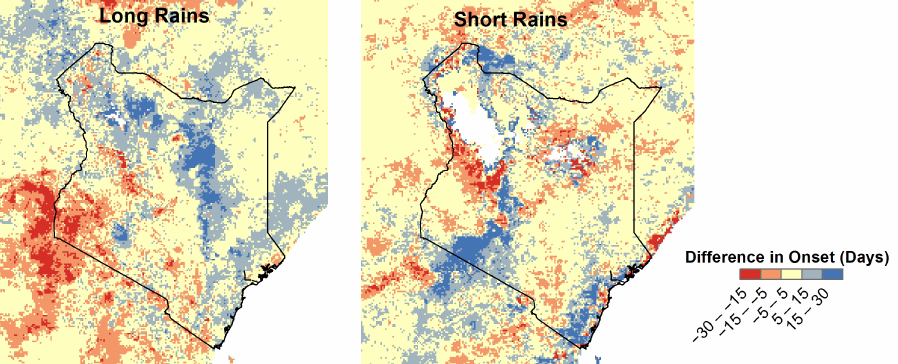
Figure 2. This figure shows the average difference in onset date between CHIRPS-GEFS and CHIRPS. Negative values mean that CHIRPS-GEFS predicts a later start date than observed; positive values mean that CHIRPS-GEFS predicts an earlier start